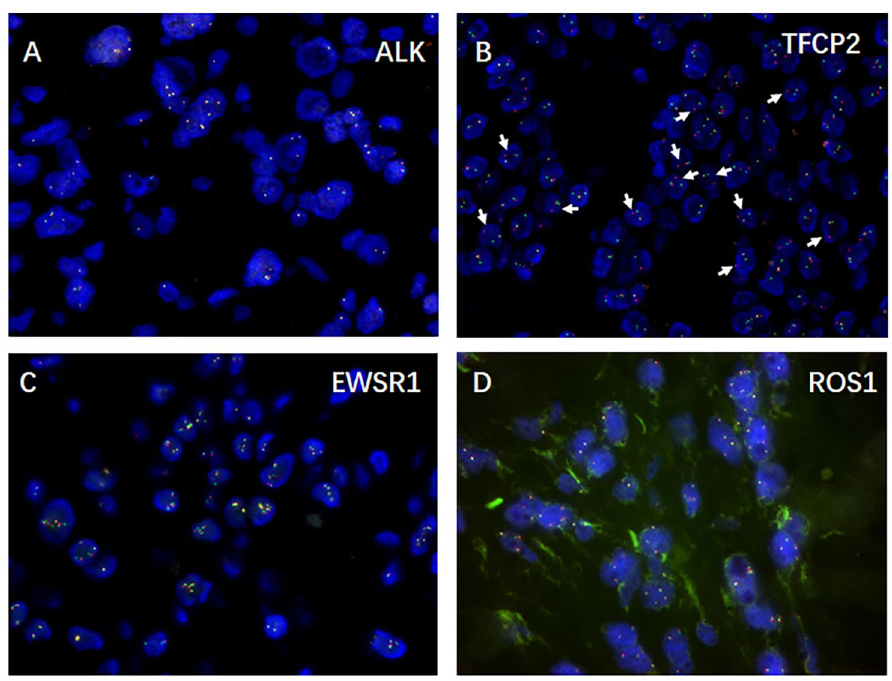
Fig. 3 Molecular genetic findings of epithelioid and spindle cells rhabdomyosarcoma: Fluorescence in situ hybridization assay showed no ALK rearrange- ment (Fig. 3A) but rather TFCP2 rearrangement (Fig. 3B), the increased copy numbers of EWSR1 gene (Fig. 3C) and ROS gene (Fig. 3D).